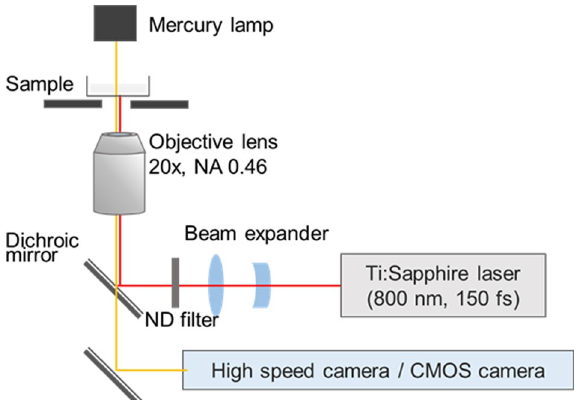
Figure 5. Schematic illustrations of the femtosecond laser induced gas bubble generation and observation system coupled with the inverted optical